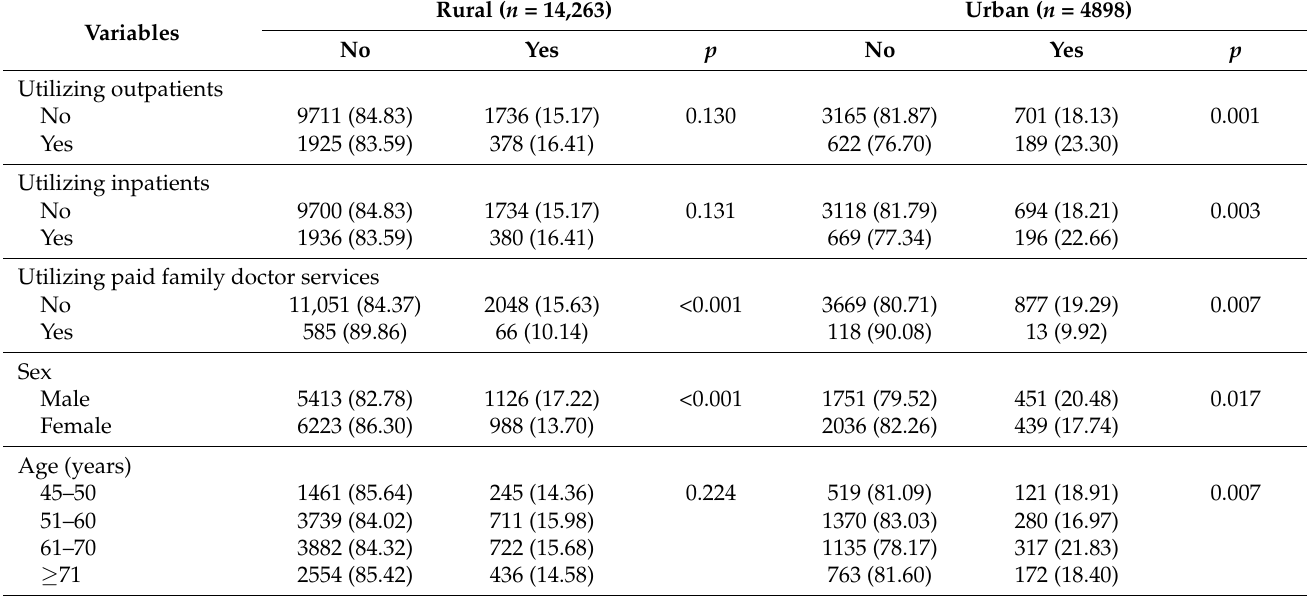
Table 4. Distribution of rate of dissatisfaction with local medical